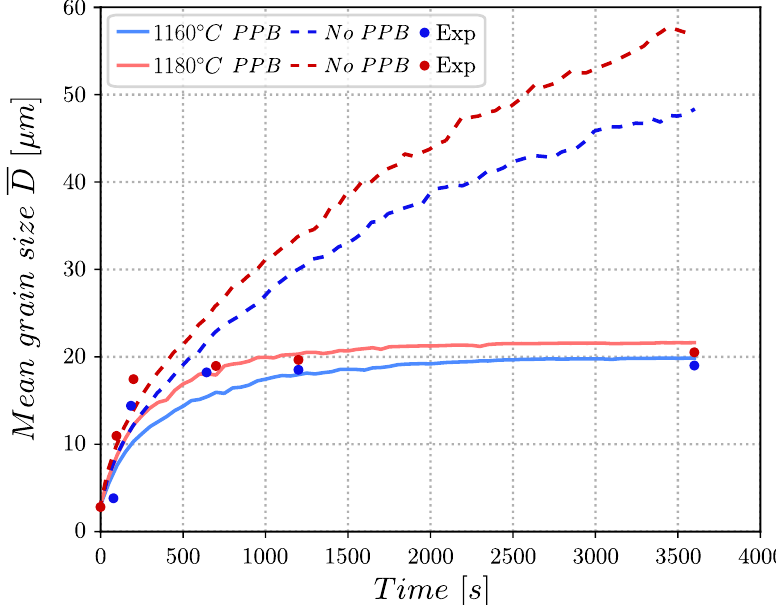
Figure 13. GG simulations at supersolvus temperatures to calibrate and validate the identified the GB migration parameters M 0 and Q m values for the N 19